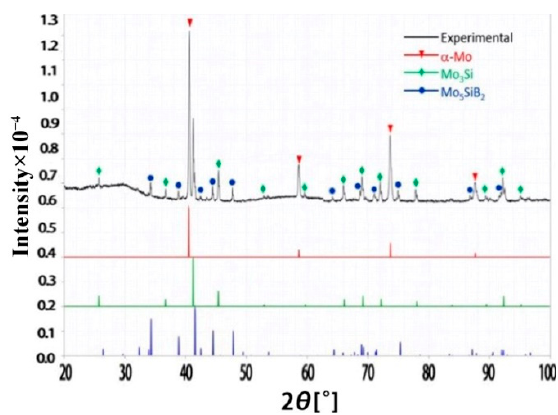
Figure 4. The XRD results of laser remelted Mo-12Si-8.5B alloy.